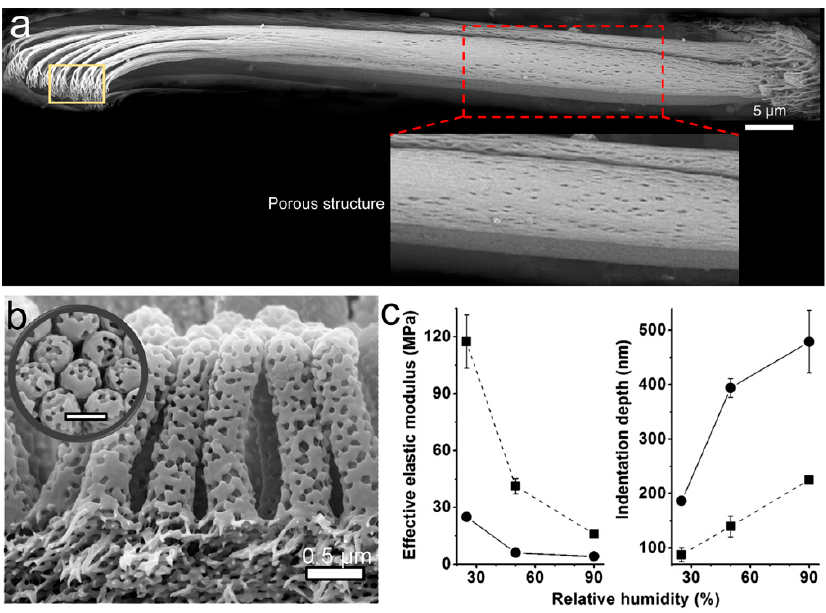
Figure 8. Biological and bioinspired porous pillars for adhesion. ( a ) Scanning electron microscopy (SEM) image of a single dried seta of tokay gecko (some pores can be found on the stalk). Reproduced with permission from [10]; ( b ) SEM image of the porous fibrillar polystyrene ‐ b ‐ poly(2 ‐ vinyl pyridine) (PS ‐ b ‐ P2VP) adhesive. Reproduced with permission from [124]; ( c ) Effect of the relative humidity on the E eff and indentation depth. Reprinted with permission from [123]. Copyright (2013) American Chemical Society.